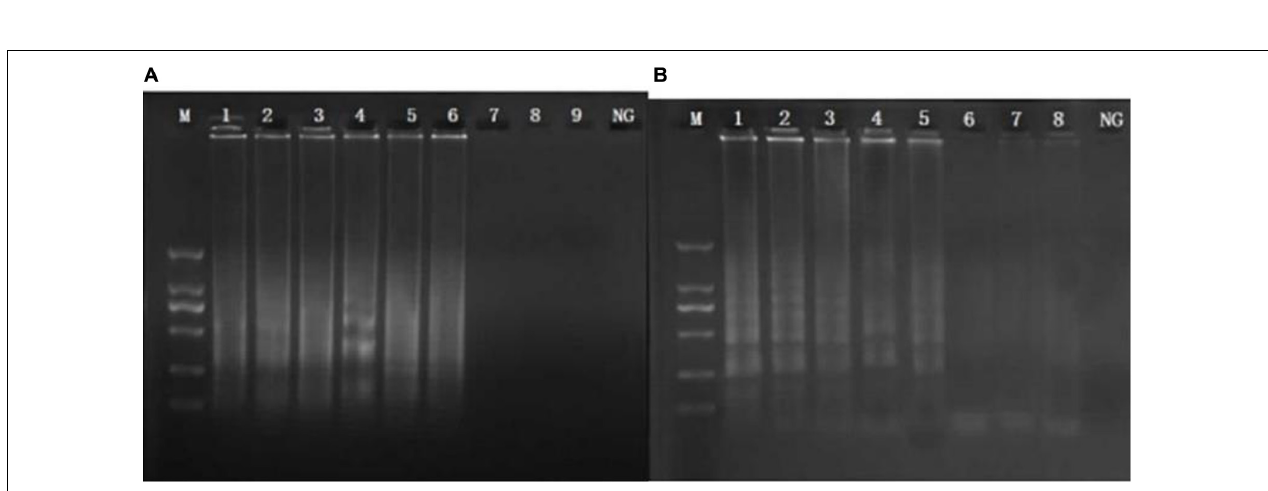
FIGURE 2 | Sensitivity of the CPA assay in genomic DNA by 1.5% agarose gel electrophoresis. Sensitivity from 10,071 of femA (A) and mecA (B) genes. M, DNA marker; lanes 1–8, 3.0 ng/ µ l, 300 pg/ µ l, 30 pg/ µ l, 3 pg/ µ l, 300 fg/ µ l, 30 fg/ µ l, 3 fg/ µ l, and 300 ag/ µ l; NG, negative